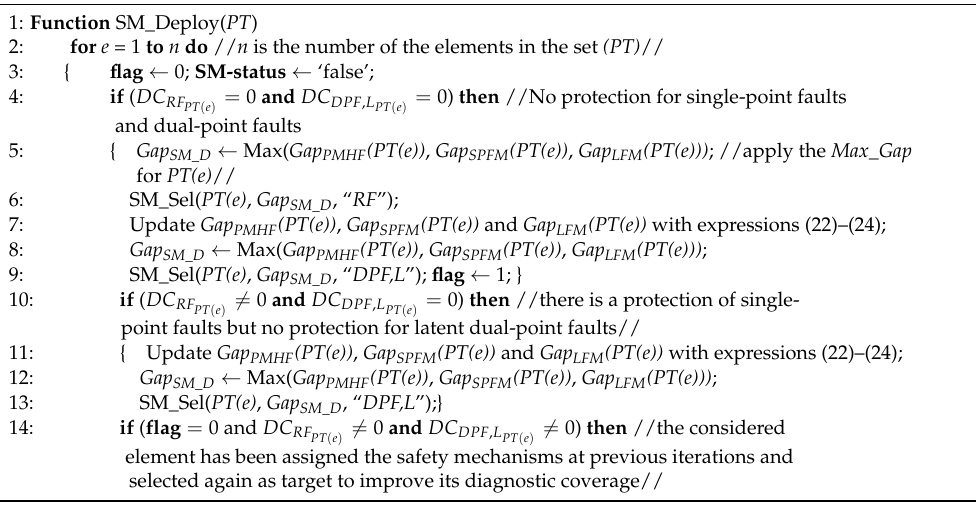
Algorithm 1: ASIL-oriented system hardware architecture